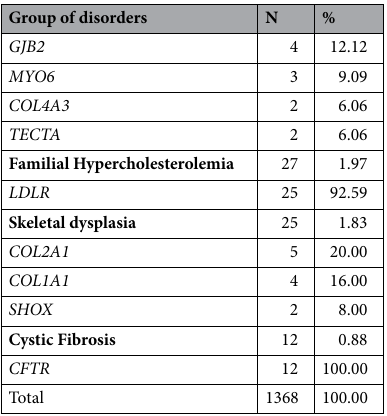
Table 3. Most frequent mutated genes in molecular diagnosis cases excluding deletions/duplications cases (n = 1368) among the different disorders and ordered by frequency. Only mutated genes observed 10 or more times or the five most mutated genes (if found more than once) among the different disorders are